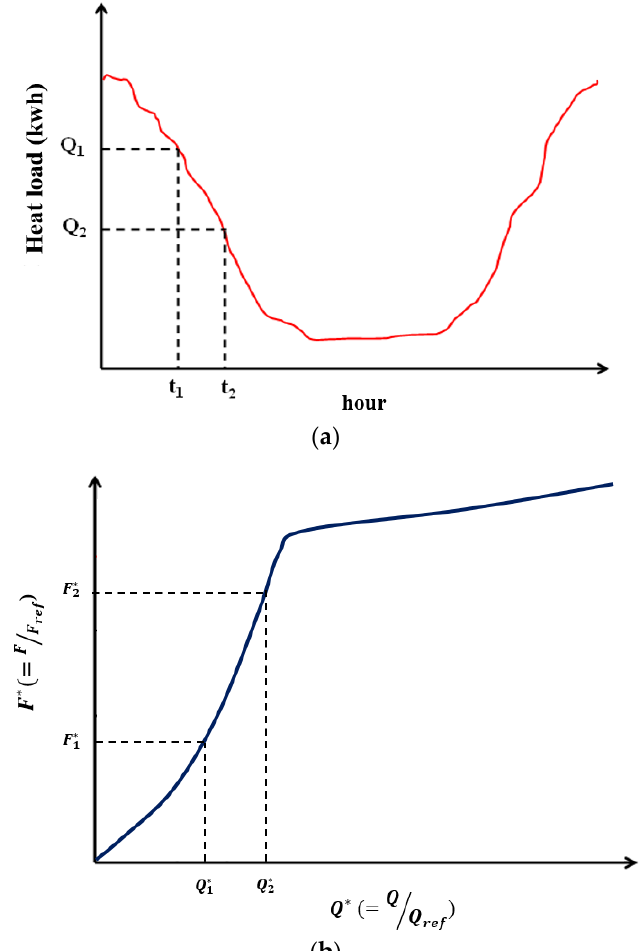
Figure 16. Illustrative diagram of the correlation between the operating variables in different analysis frameworks. ( a ) Time series based correlation analysis between operating variables. ( b ) Event-based correlation analysis between operation variables.